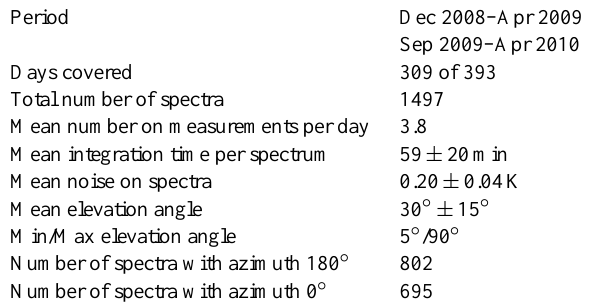
Fig. 1. Sketch of the emission lines in the spectral region around the CO line of interest calculated with ARTS to visualize the line po- sitions. The black dashed lines indicate the spectral region covered by the FFT spectrometer. Continuum emission has been omitted in the calculation of this plot.